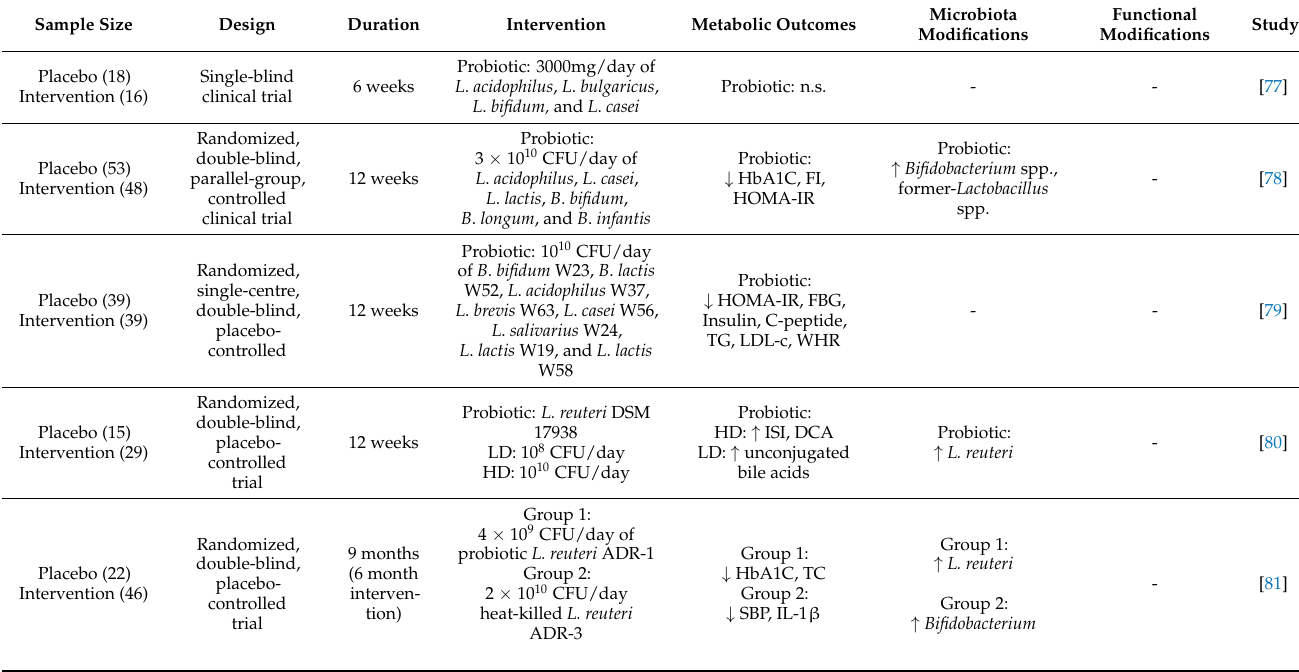
Table 3. Summary of clinical trials evaluating the effect of probiotic supplementation alone in individuals with T2DM. Sample Size Microbiota Modifications Functional Modifications